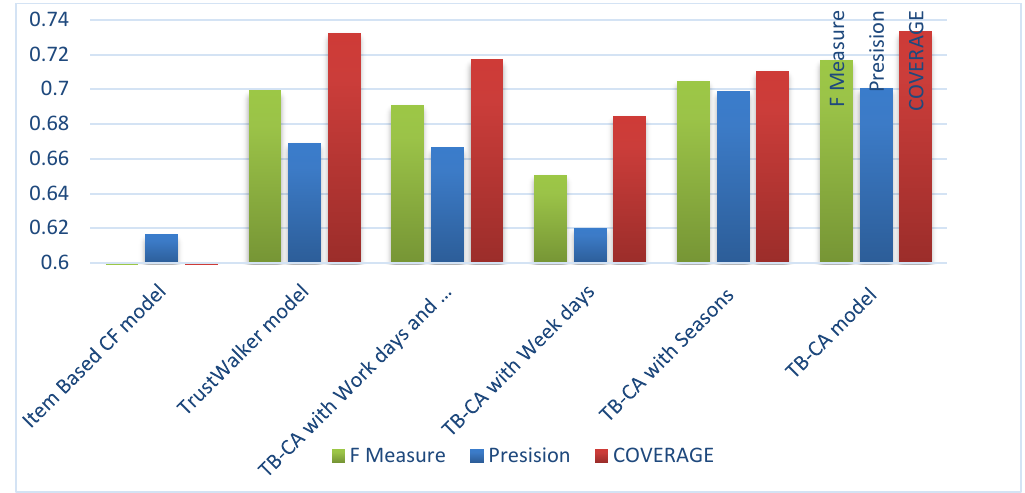
Fig. 2. Precision, coverage and F measure for different models on cold start users